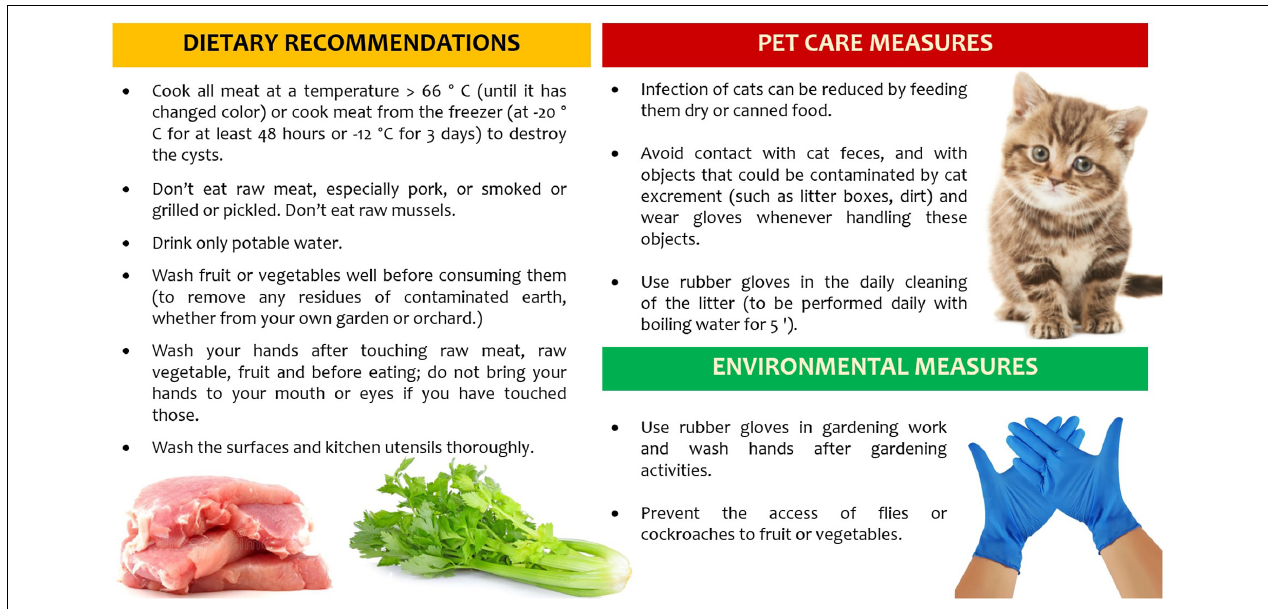
FIGURE 4 | Recommendations to prevent Toxoplasma transmission during